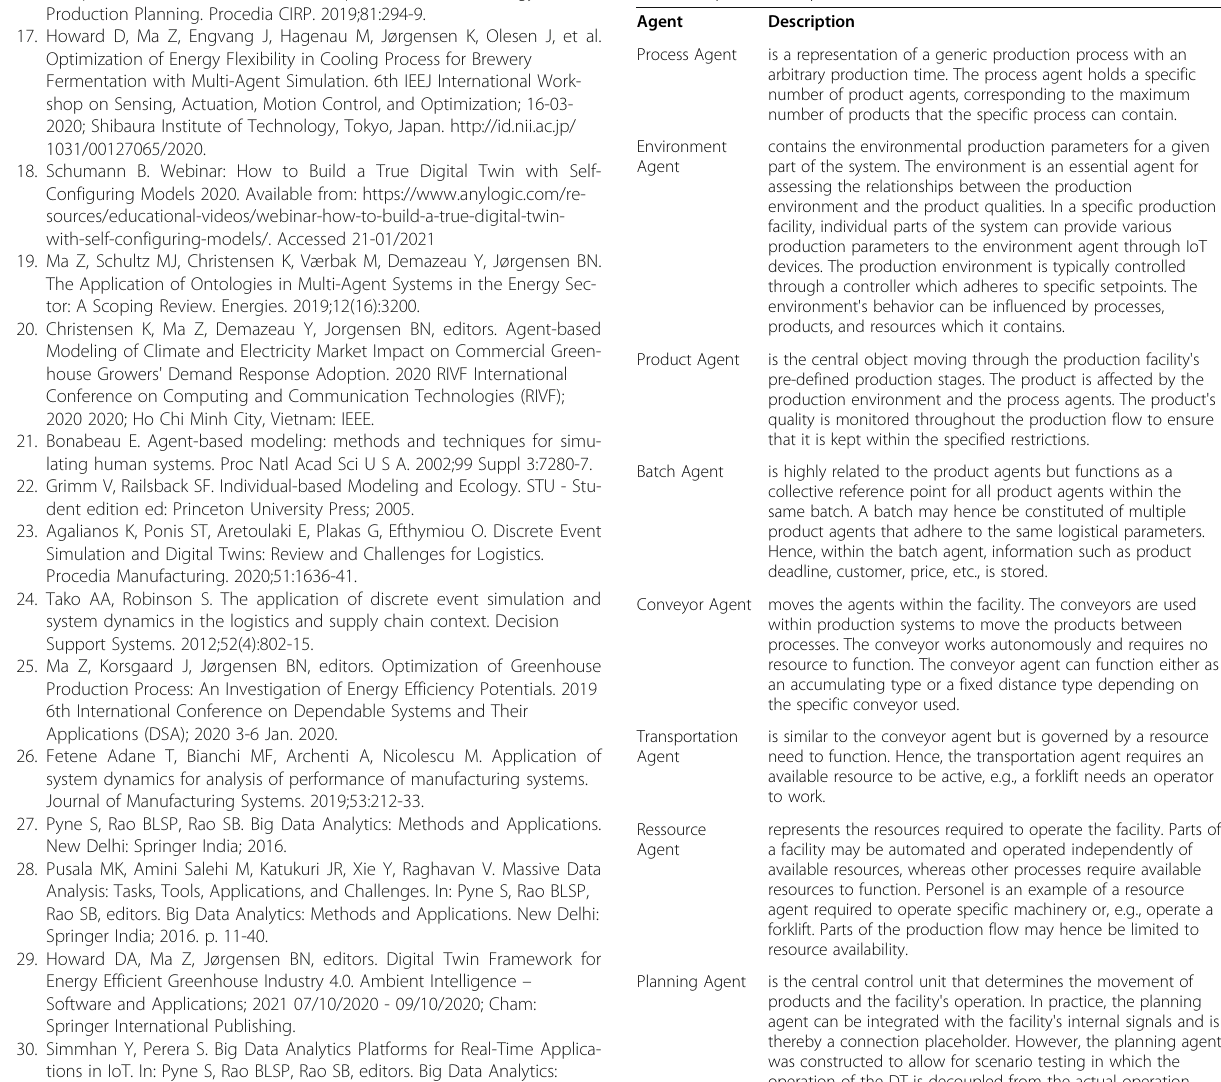
Table 1 (Abstract P9). Agent list in the digital twin framework for industrial production